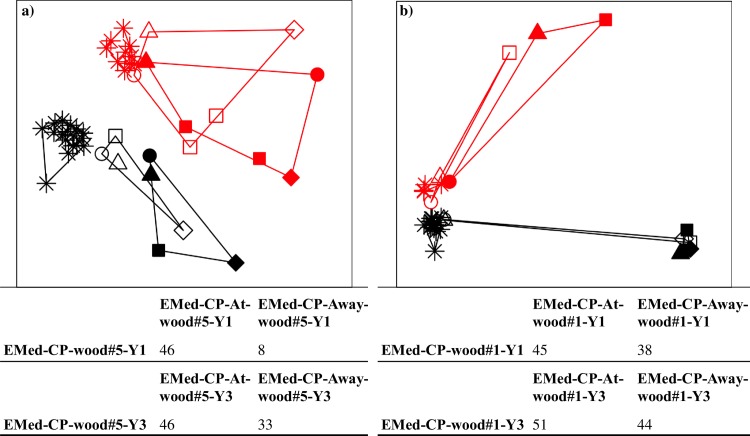
NMDS analysis depicting differences in the structure between wood and sediment bacterial communities.Analysis were performed using Bray-Curtis dissimilarity based on the ARISA dataset. “At wood” (open symbols) and “Away wood” (closed symbols) samples changed with time in (a) EMed-CP-wood#1 and (b) EMed-CP-wood#5 experiments. Communities sampled after 1y of immersion are colored in black and communities after 3y in red. Different symbols of the sediment communities refer to the depth horizon sampled (circle = 0–1 cm, triangle = 1–2 cm, square = 4–5 cm and rhomb = 9–10cm), while wood samples are depicted with an asterisk. Note that topmost surface 0–2 cm “At wood” samples (open symbols) contained variable amounts of wood-chips mixed with sediment. NMDS plot (a) stress = 18% and NMDS plot (b) stress = 7.5%. Percentage of the shared ARISA OTUs between the wood and the sediment “At wood” and “Away wood” samples for the different immersion times is given in the tables below the NMDS panels. See S8 Table for associated results of the ANOSIM test.